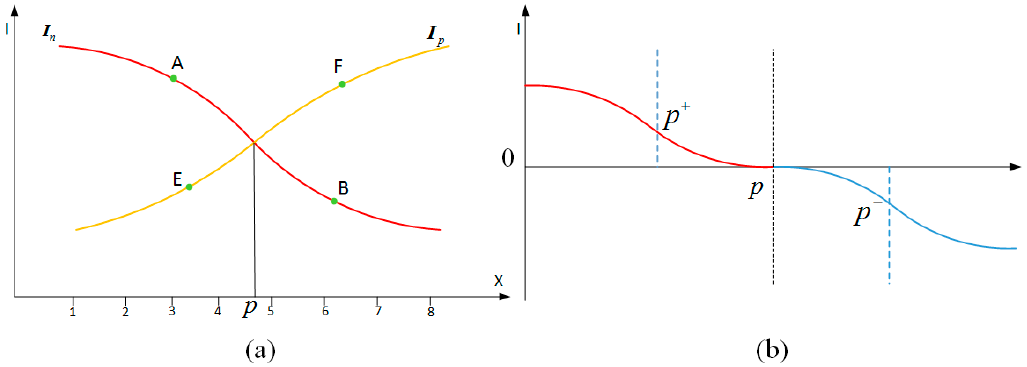
Figure 3. Stripe detection methods. ( a ) Using normal and inverse stripe pattern; ( b ) The improved detection method for shiny surface.